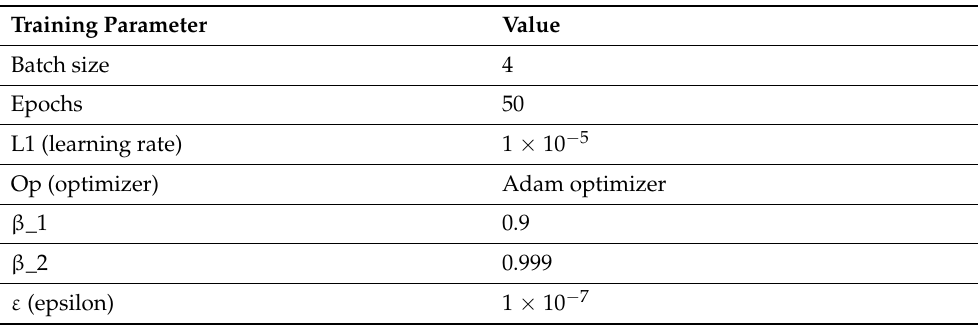
Table 2. Training Parameters for Customized AlexNet and Inception